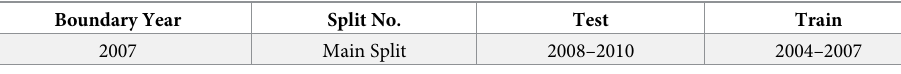
Table 2. Dataset division into training and testing splits.